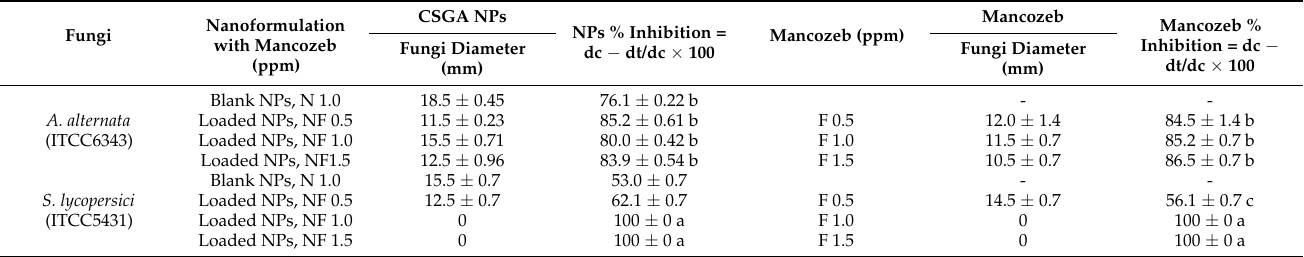
Table 3. In vitro antifungal efficacy of mancozeb-loaded (1.0 mg/mL) CSGA-1.0 nanocomposites.